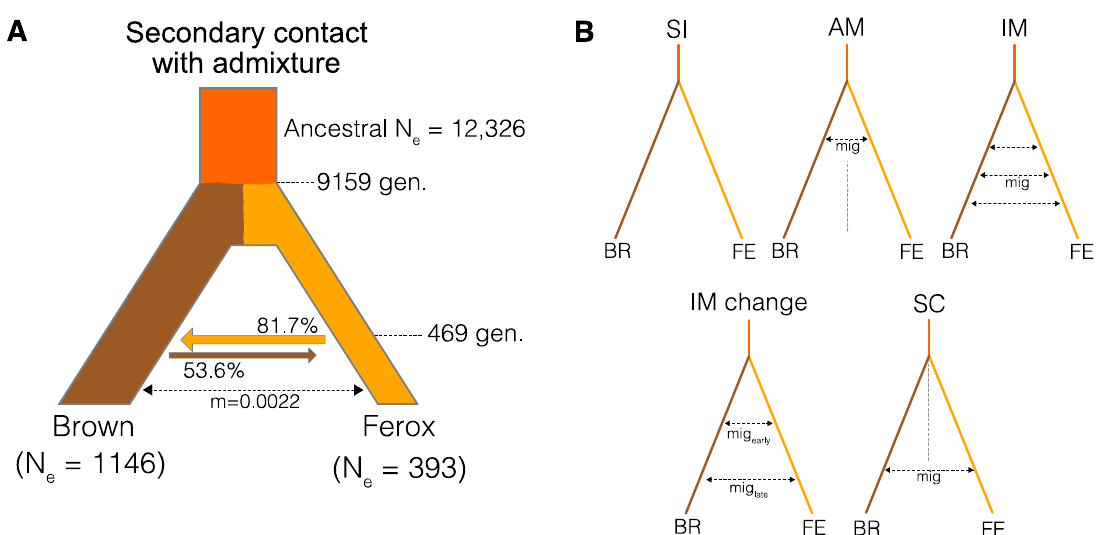
Figure 3. Evolutionary history of divergence between ferox trout and benthivorous brown trout. ( A ) Illustration of the most likely model of divergence between ferox trout and benthivorous brown trout. Point estimates for all estimated parameters are given. Confidence intervals are given in Table 3. ( B ) Illustrations of the remaining tested models between benthivorous brown trout (BR) and ferox trout (FE). Table 3. Selection of demographic models. Table 3. Mean parameter estimates and confidence intervals (CI) for the secondary contact with introgression demographic model.